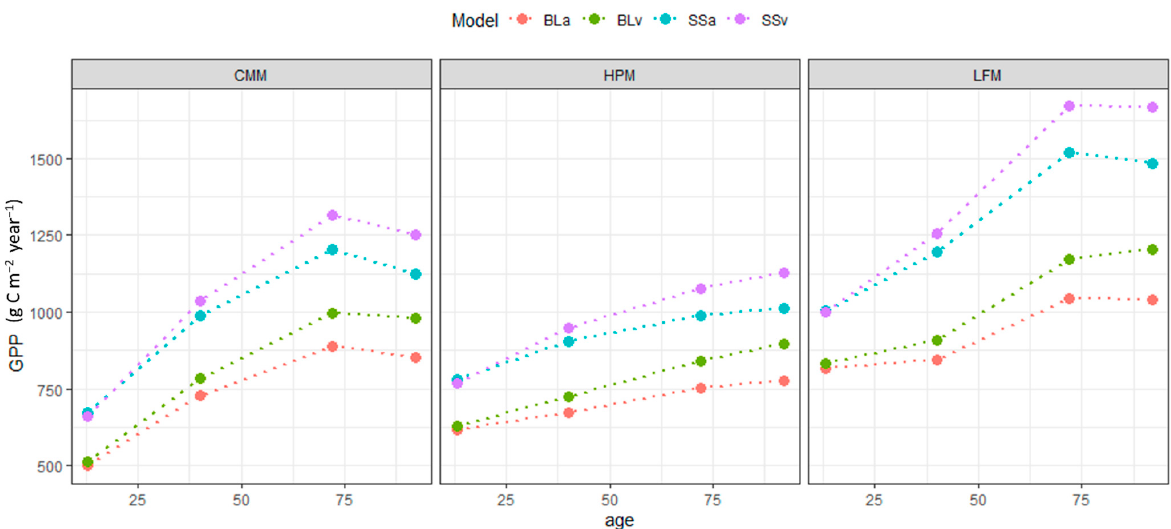
Figure 3. Gross Primary Productivity (GPP) monthly estimations for the examined period by the Big Leaf model with average A sat and K m , (BLa)—red line, Big Leaf with variation of A sat and K m (BLv)—green line, Sun/Shade model with av- erage A sat and K m , (SSa)—blue line, and Sun/Shade model with variation of A sat and K m , (SSv)—purple line for all three methods of LAI estimation, ceptometer method (CMM), hemispherical photography method (HPM) and litterfall method (LFM).